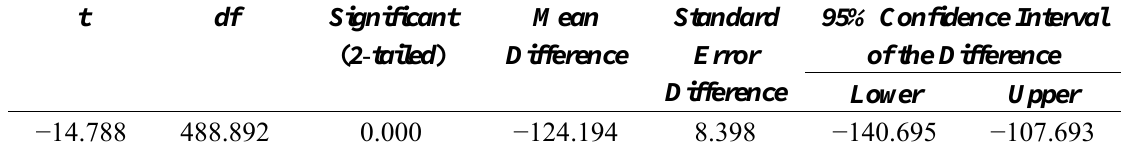
Table 10. T - test on speed of retweeting of post linking photos vs . videos (H5).